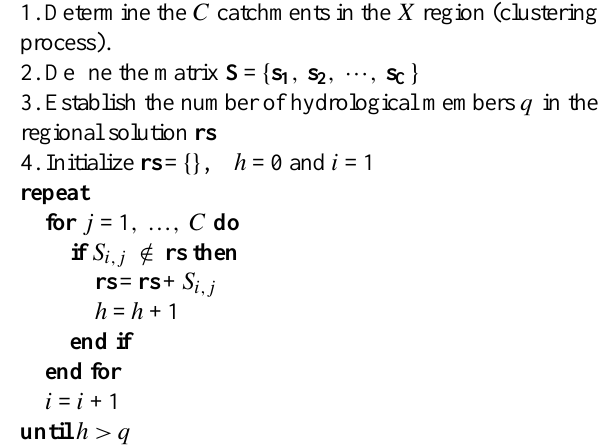
Algorithm 2 Regional integration mechanism